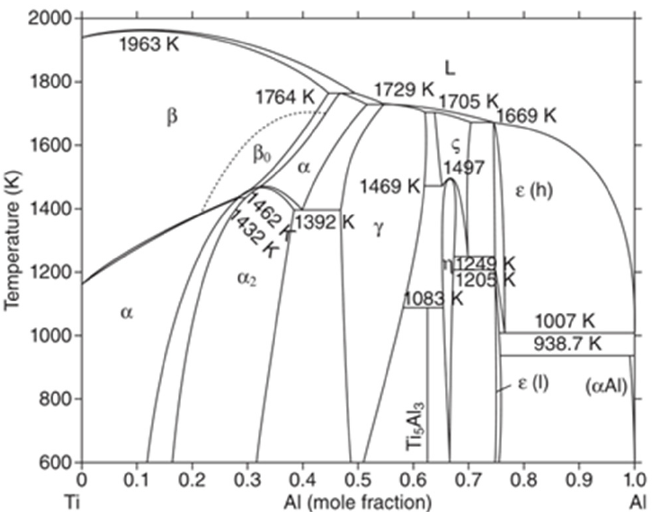
Figure 4. Al–Ti phase diagram ( α : α -Ti, β : β -Ti, α 2 : Ti 3 Al, γ : TiAl, ε : TiAl 3 , L: liquid).